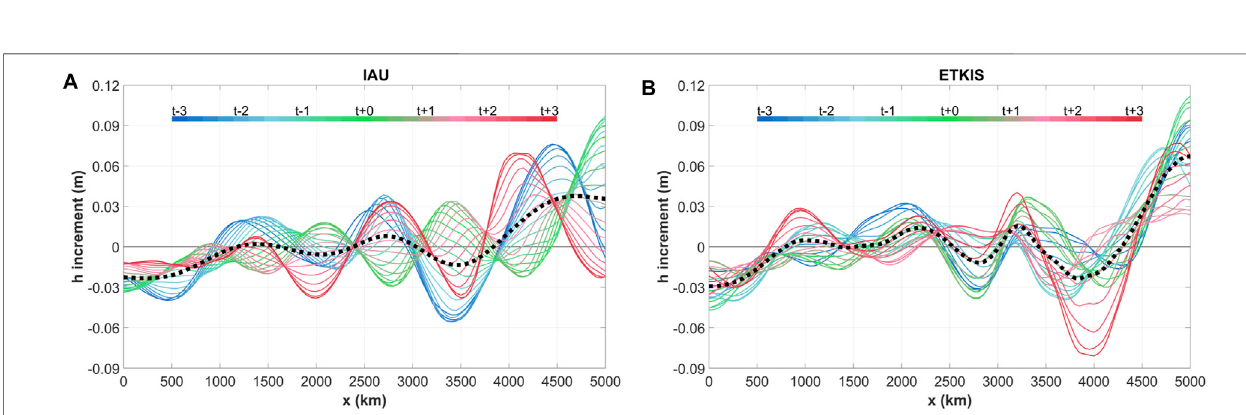
Frontiers in Applied Mathematics and Statistics |